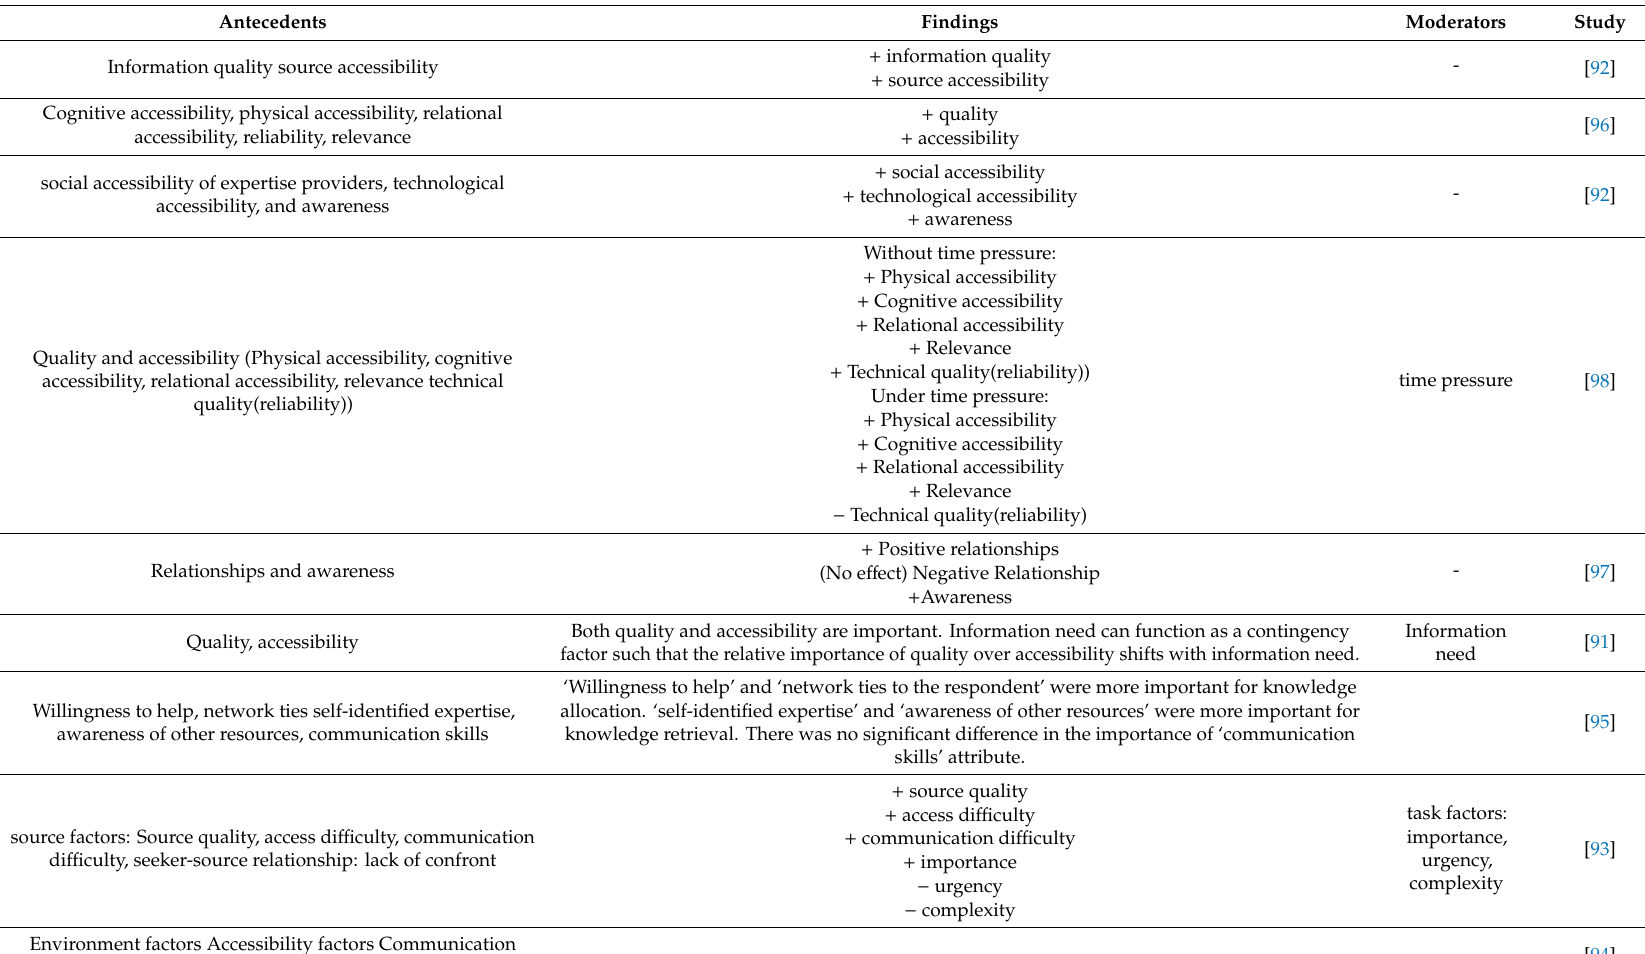
Table 6. Contextual factors in expertise